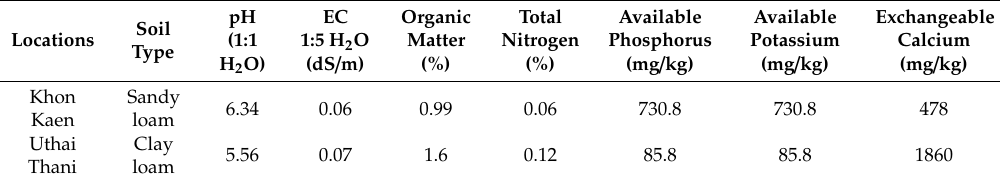
Table A1. Soil physical and chemical